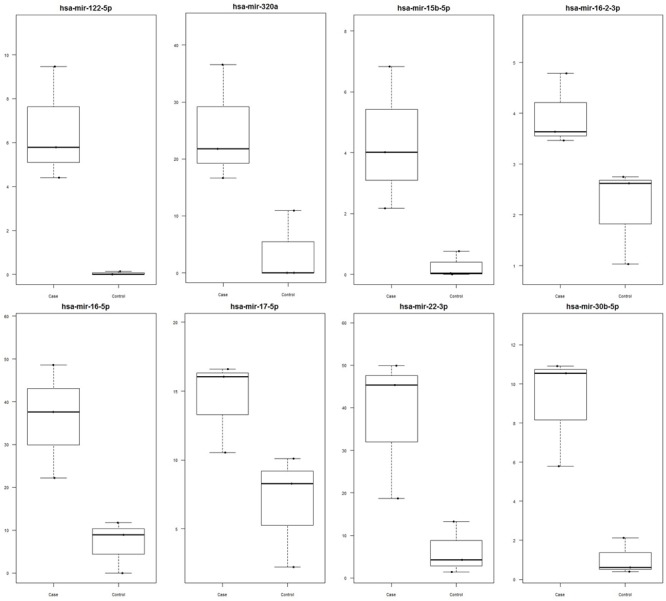
Significantly upregulated miRNA in female versus male media as determined by Firefly® Circulating miRNA Assay Immunology Panel of 68 miRNAs (ABCAM, Cambridge, MA, USA). Data are represented as signal values for each sample. miRNAs miR-122 (P-value = 0.048), miR-16 (P-value = 0.042), miR-30b (P-value = 0.029), miR-320a (P-value = 0.042), miR-15b (P-value = 0.089), miR-16-2 (P-value = 0.061), miR-17 (P-value = 0.072), and miR-22 (P-value = 0.069) were found to be significant. Female media is represented as case and male media is represented as control.